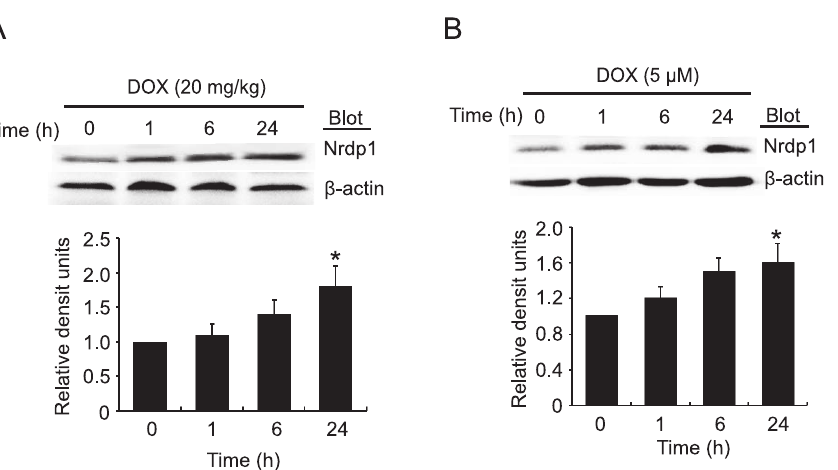
Figure 1. DOX stimulates Nrdp1 protein expression. Time-course of the protein expression of Nrdp1 in mouse hearts (n=3) after intraperitoneal (ip) injection of 20 mg/kg DOX (A) or in neonatal rat cardiomyocytes after 0.5 m M DOX treatment (B). b -actin was used as a loading control. Quantitative analysis is in bottom panels (n=3 experiments for each time points). * P , 0.05 vs 0 hour.